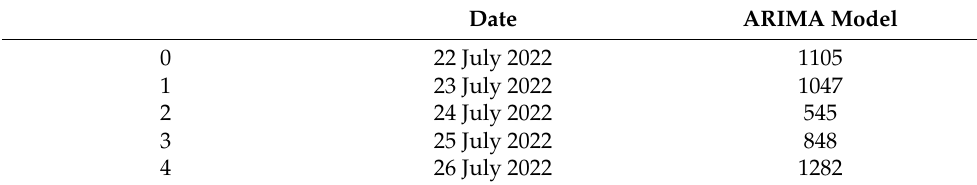
Table 7. ARIMA model confirmed case prediction for five days.